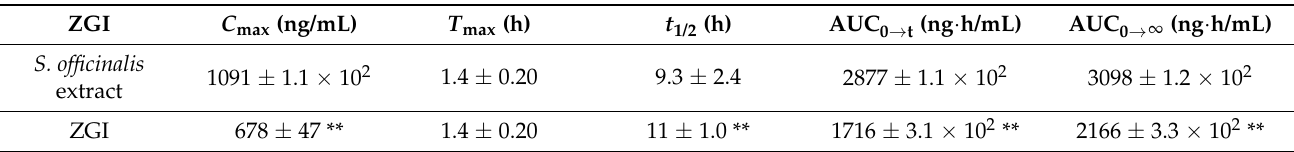
Table 5. Mean plasma concentration–time curve of ZGI between those of the S. officinalis extract and the pure ZGI administration. ( n = 6) (Compared with S. officinalis extract; ** p < 0.001).